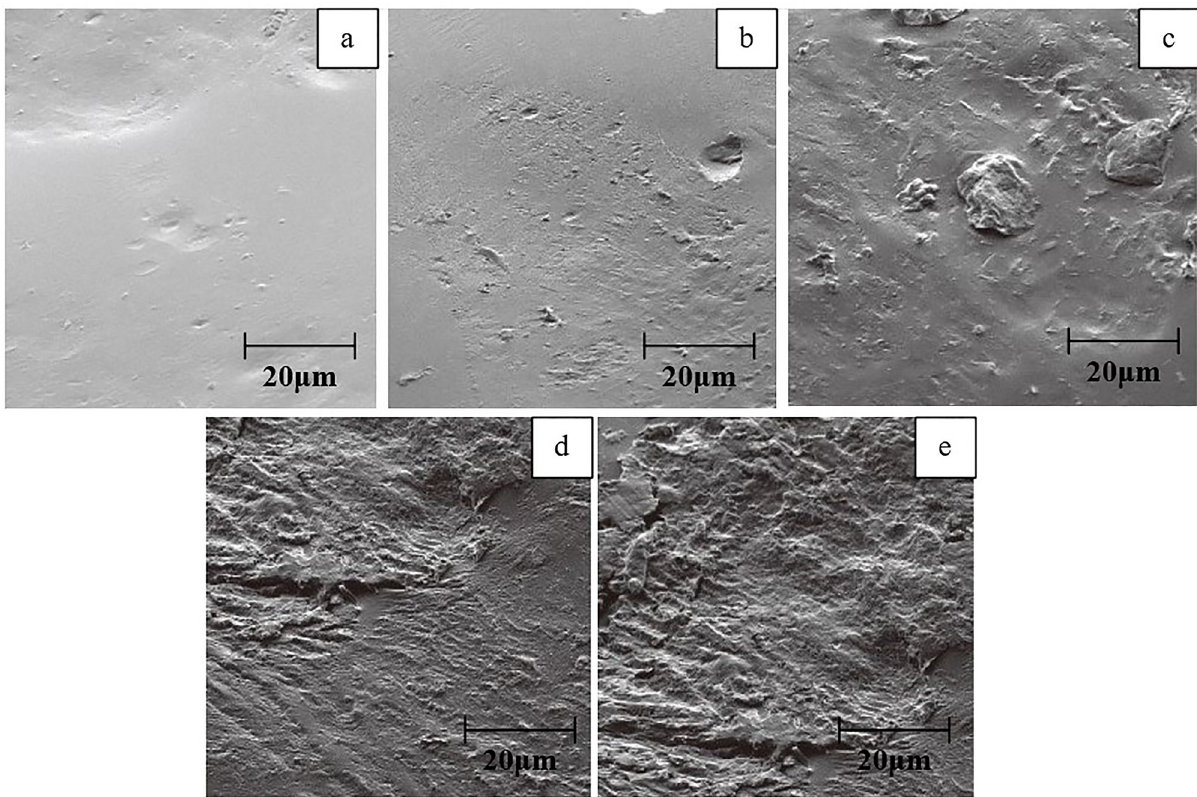
Figure 8: Scanning electron micrographs of fracture surfaces with different nano-HA contents [51] (a) PLLA; (b) 10% nano-HA; (c) 20% nano- HA; (d) 30% nano-HA; (e) 40%